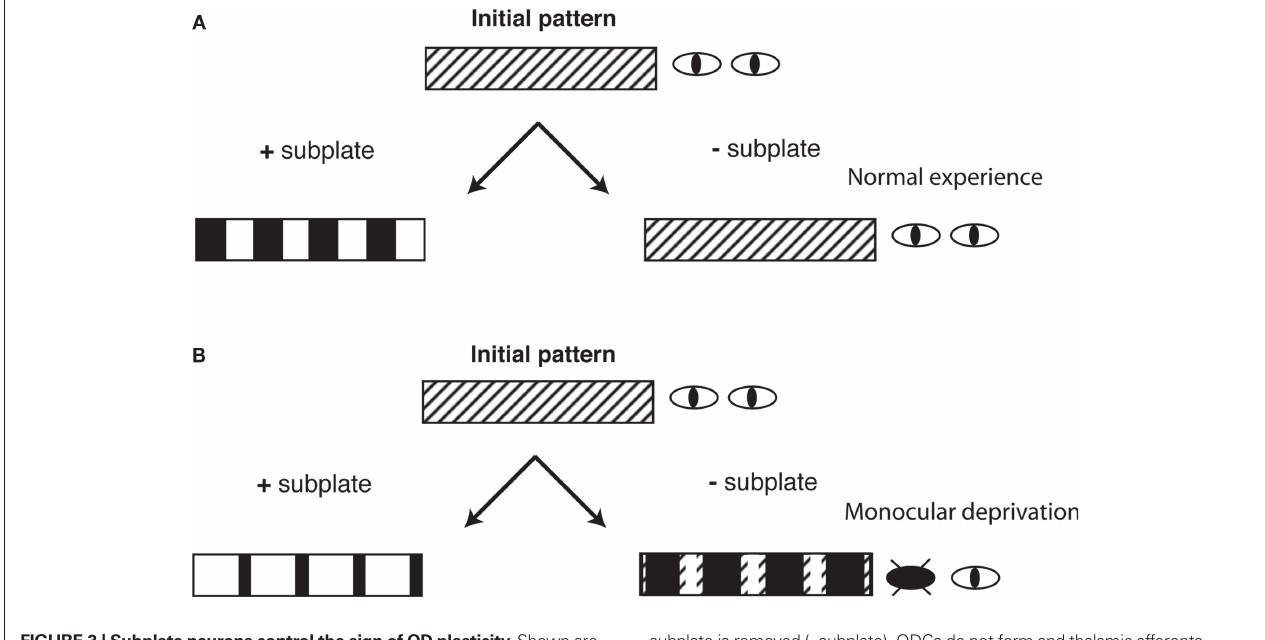
FIGURE 3 | Subplate neurons control the sign of OD plasticity. Shown are schematic diagrams of the ocular dominance columns in cat visual cortex under 4 conditions. ODCs form from an initial non-segregated pattern at early stages of development. (A) With normal experience and with subplate present ( + subplate), each eye is represented in equally large regions of visual cortex. If